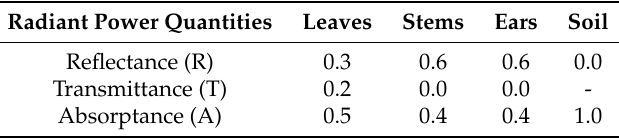
Table 1. Fixed artificial optical properties.